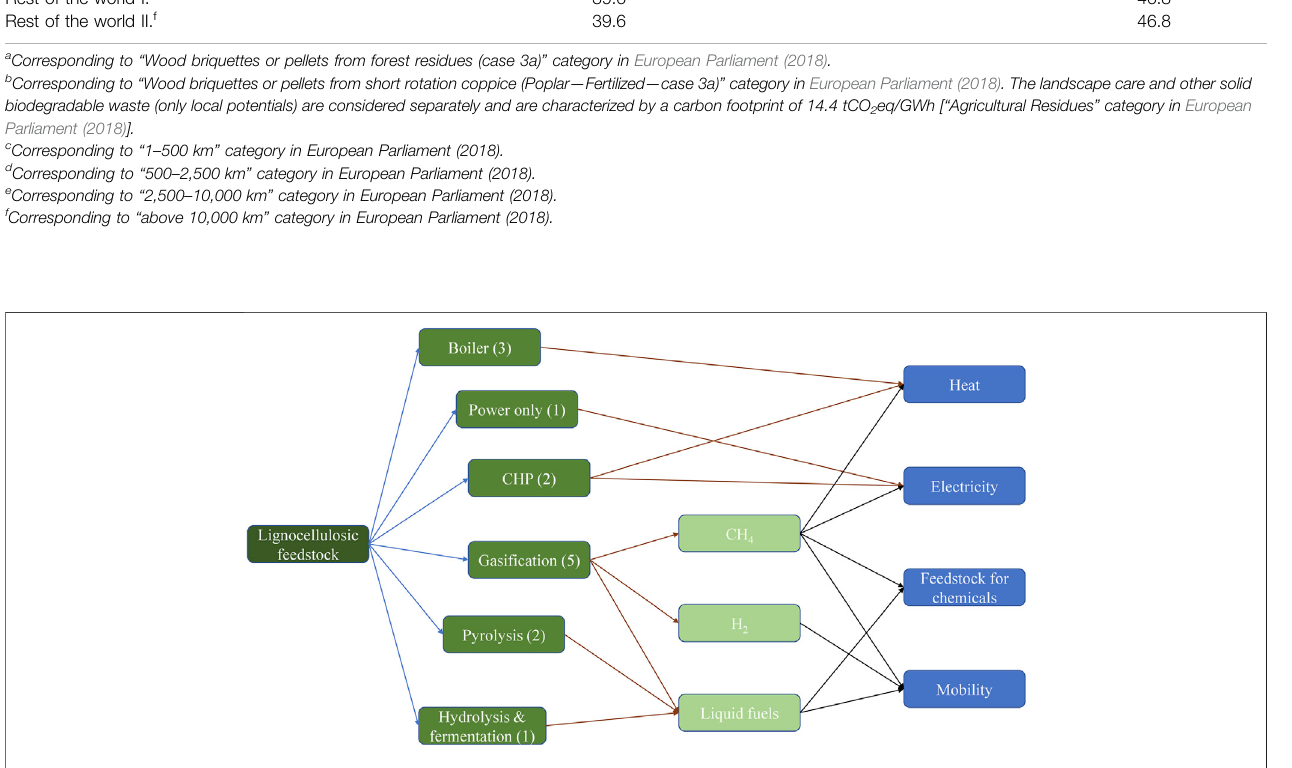
Frontiers in Energy Research |